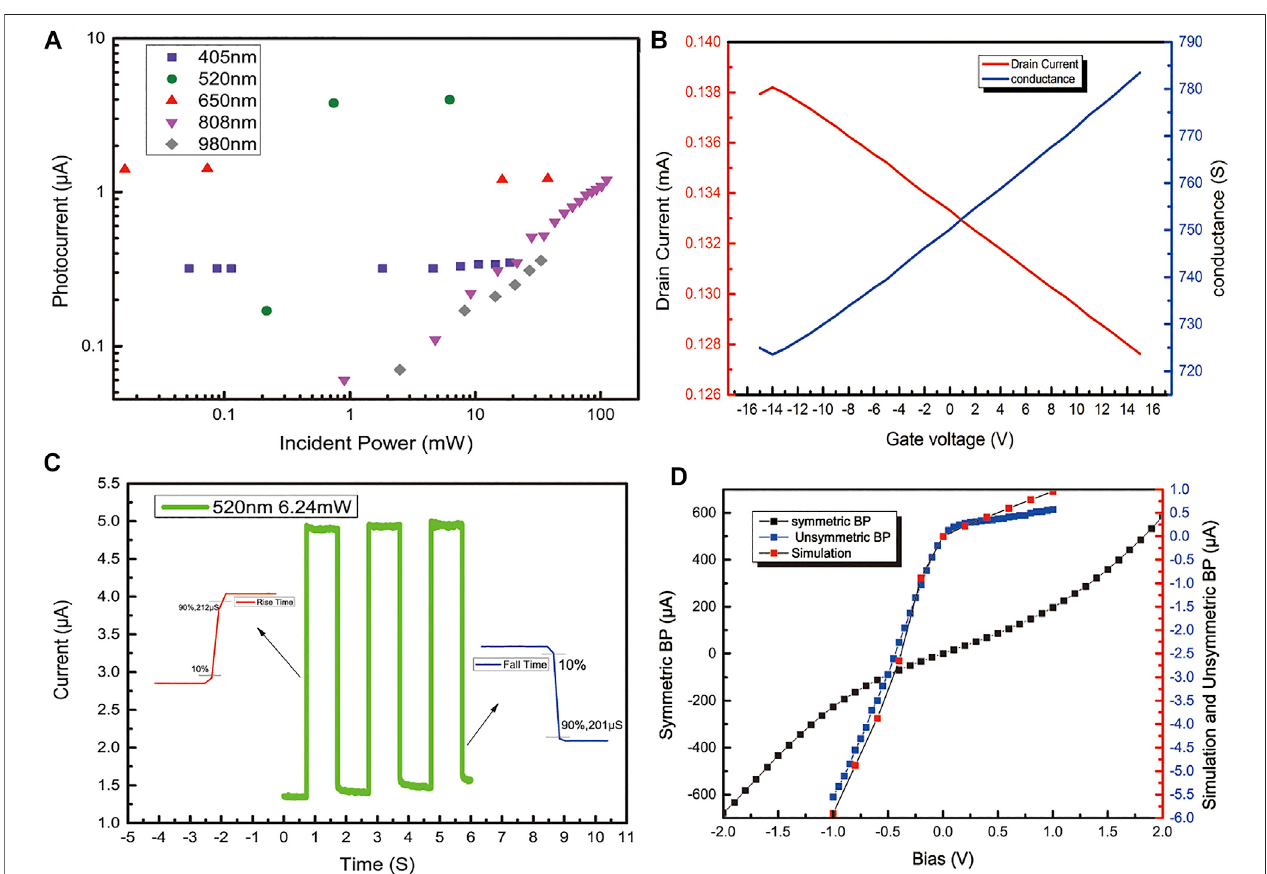
FIGURE 2 | Saturation absorption and simulation parameter extraction of asymmetric BP. (A) Photocurrent as a function of incident power for a wide waveband from 405 to 980 nm. In the visible waveband, a maximum photocurrent is observed, and saturable absorption feature is clear. (B) Transfer characteristic curve of a symmetric bulk BP sheet. (C) Response time of asymmetric BP under a 520-nm laser. (D) Voltage-ampere characteristic curve of simulation and experiment results of BP.